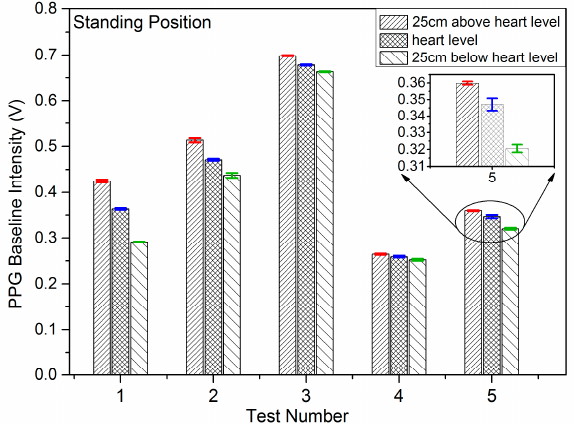
Figure 7. PPG baseline amplitudes and standard deviations when the subjects were in the standing position and the finger sensor probe set at three different vertical levels.